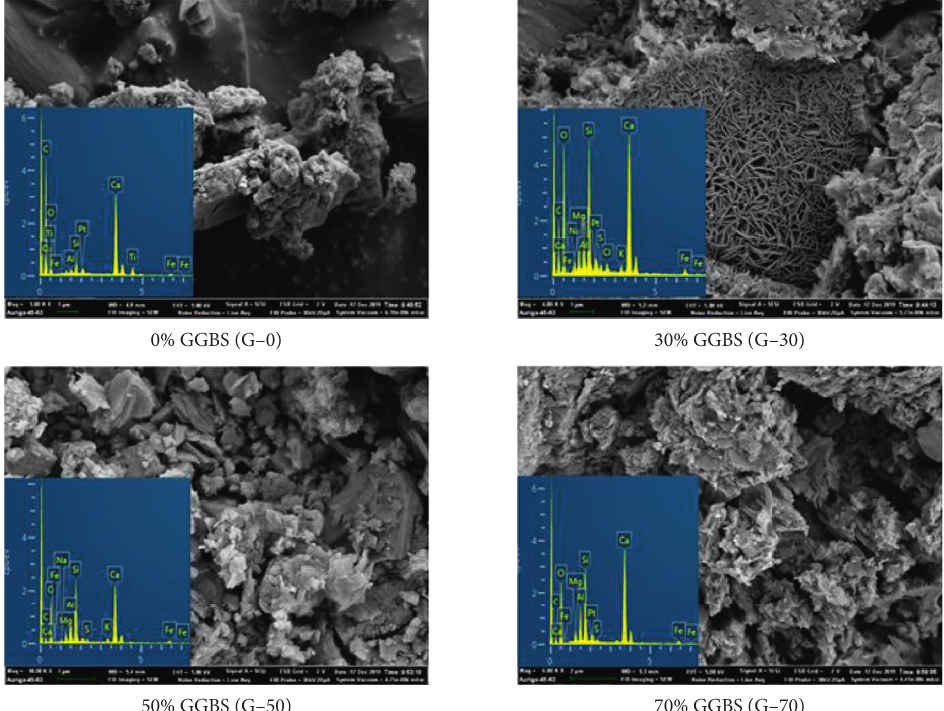
Figure 9: SEM and EDS images of carbonated concrete specimens with different %GGBS after accelerated carbonation exposure.